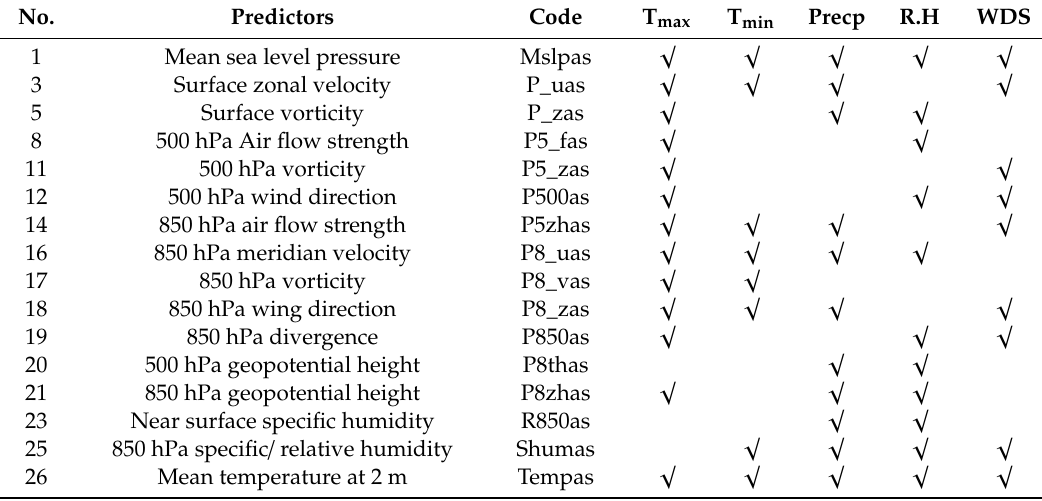
Table 3. Screening of most appropriate NCEP predictor variables depicted good correlation with observed climate